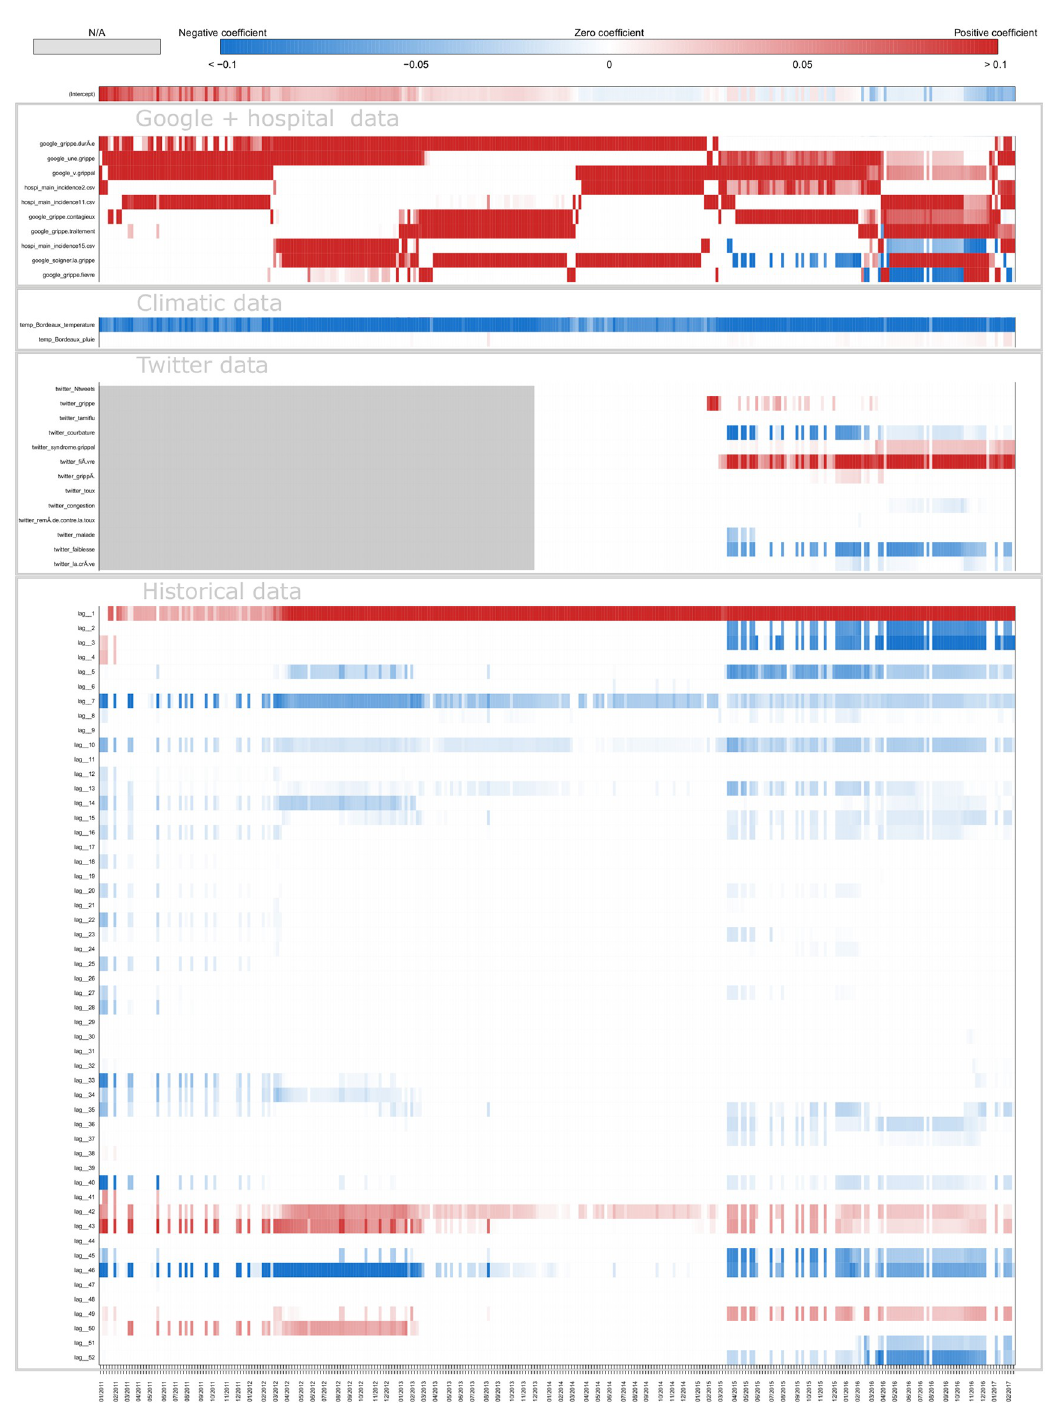
Fig 9. Coefficients Nouvelle-Aquitaine real-time